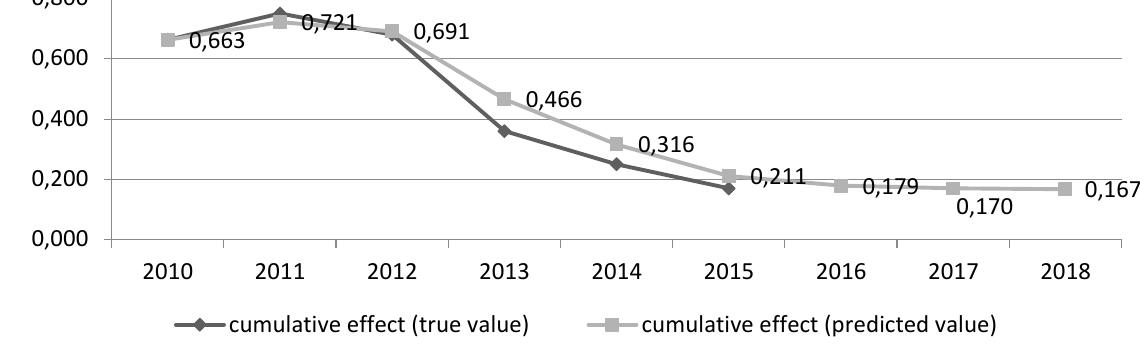
Figure 3. The dynamics of the predicted value for the cumulative effect at PJSC “Kryukov Railway Car Building Works”